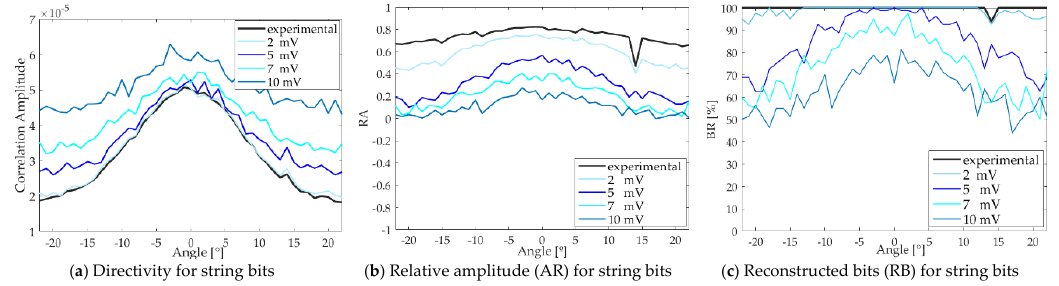
Figure 9. Influence of the noise in the secondary beam for the string of bits (experimental) and the ones adding some white noise of different amplitude: 2, 5, 7 and 10 mV. ( a ) Directivity; ( b ) Relative amplitude; ( c ) Reconstructed bits.